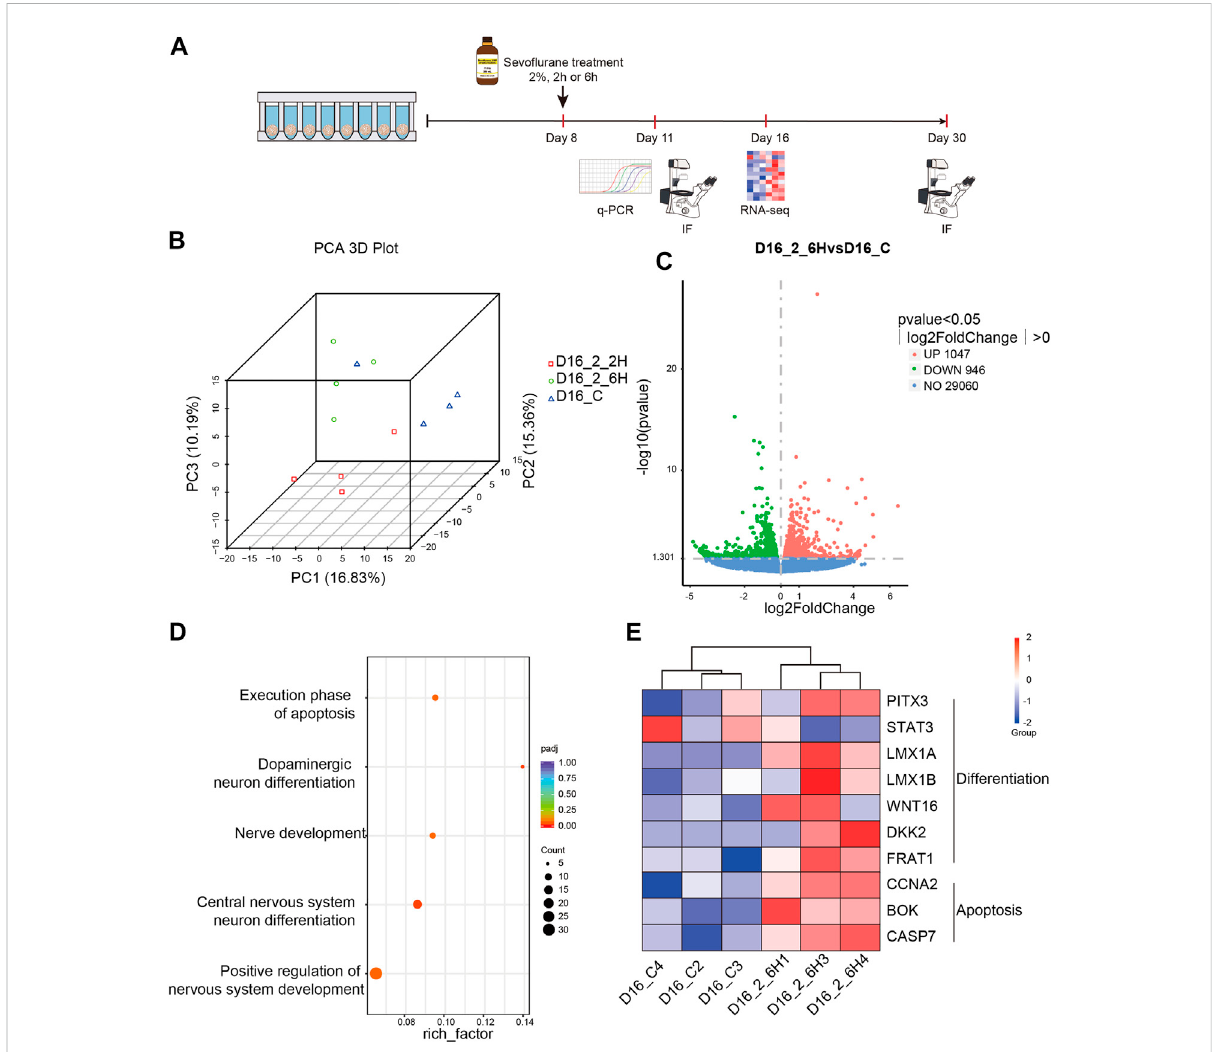
FIGURE 5 Sevo fl urane exposure alters the transcription in hMBOs. (A) Principal Component Analysis (PCA) showed little difference within the group. (B) Volcanic map showed the differential gene expression between the MBO-SF-2%6H and control groups. (C) Gene Ontology (GO) of enriched genes in the MBO-SF-2%6H group compared with the control group. (D) Differential gene expression analysis showed the differential gene expression in neural differentiation and apoptosis between the MBO-SF-2%6H group and the control group. (E) Violin Plot showed the up-regulation of important transcription factors in the midbrain development of the MBO-SF-2%6H group compared with the control